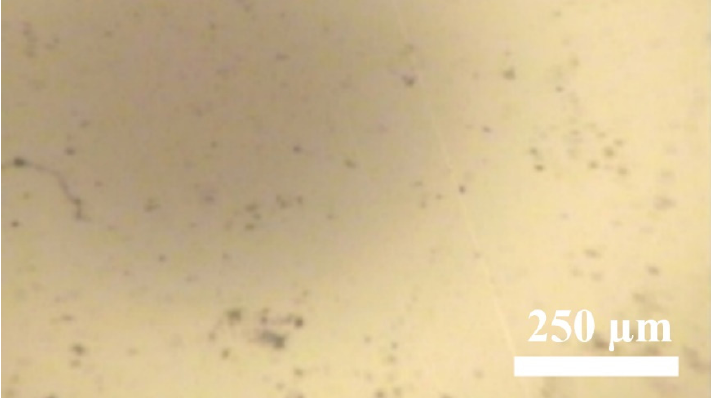
Figure 1. Optical microscope image of graphene on silicon substrate.